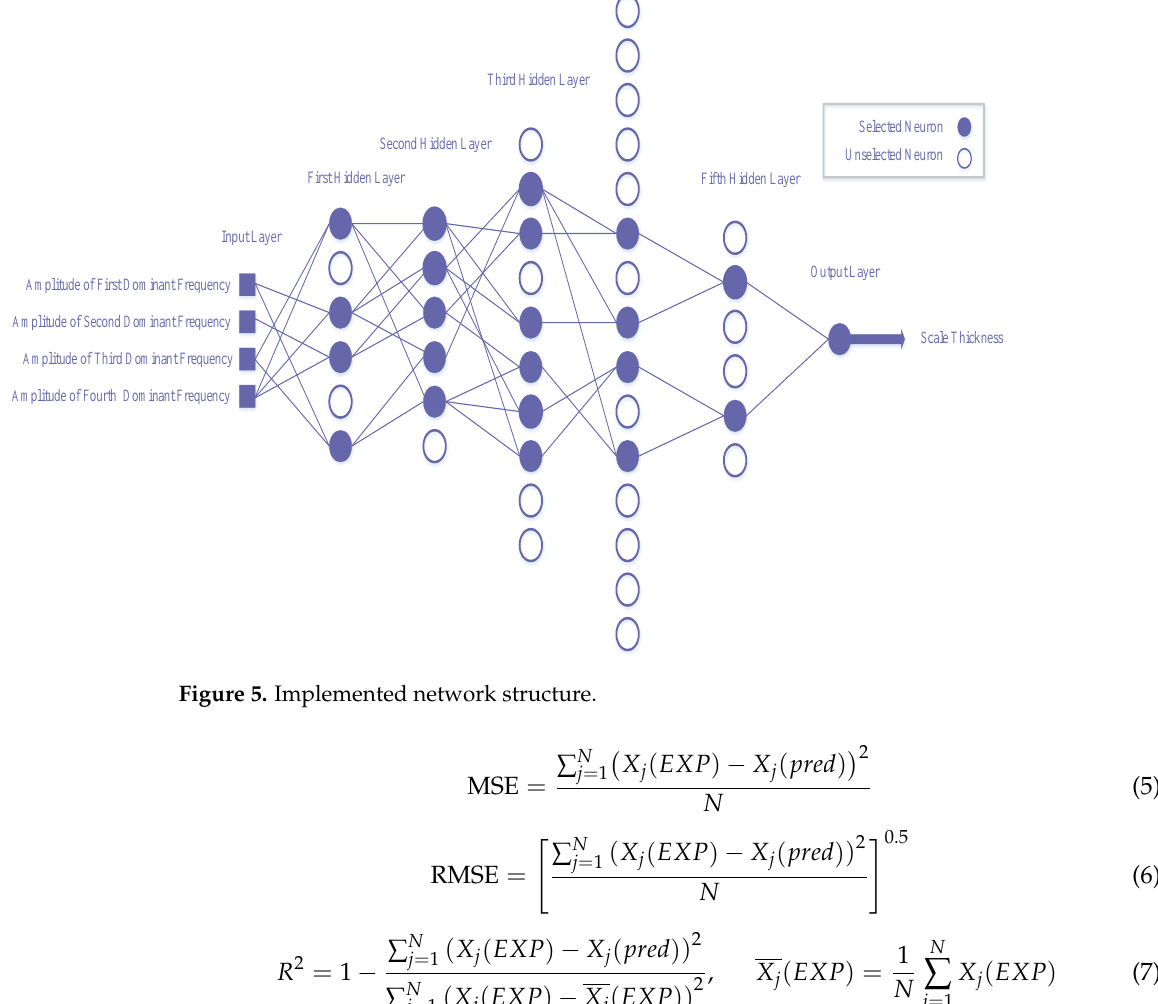
Table 1. A comparison of the accuracy between the present and former studies.